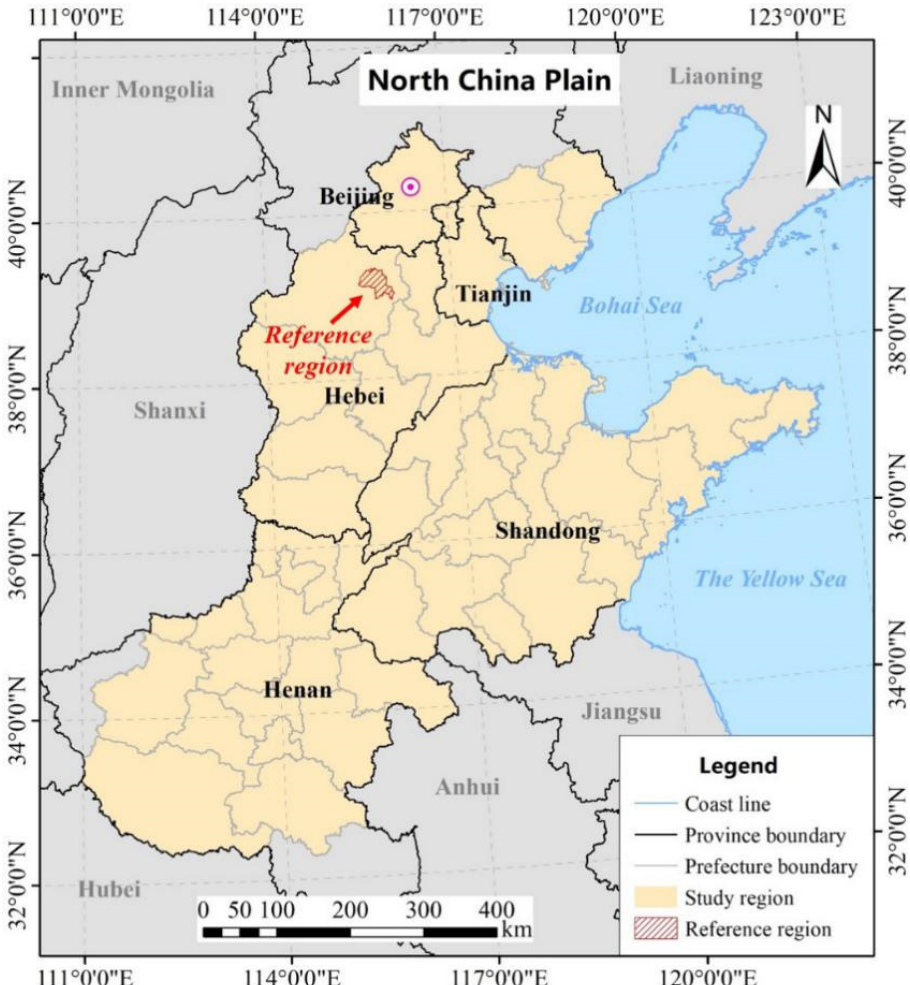
Figure 1. The study region (North China Plain) and reference region (Rongcheng county and Dingxing county). The reference region is a county, where most of the croplands were cultivated with summer maize, and we obtained a reference LAI time-series curve by averaging the LAI time series of all maize pixels retrieved from MODIS products in the reference region (Section 2.3.4). The reference LAI time series was an important factor for computing the Yp of maize (Section 2.3.4).